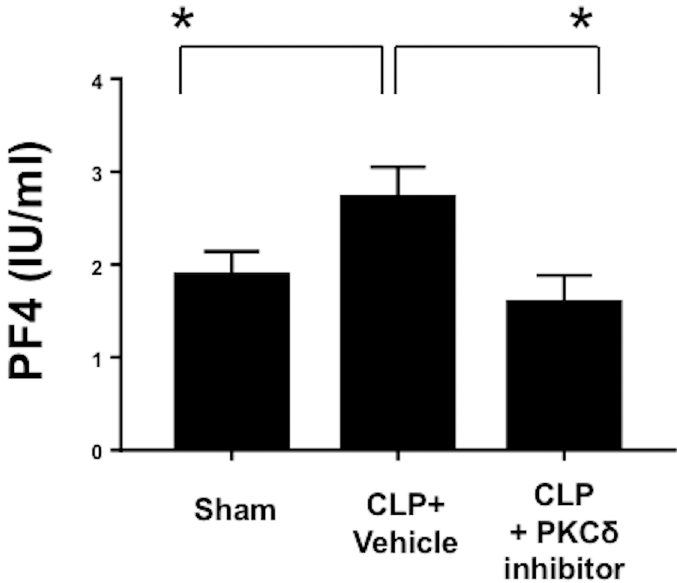
Fig 5. Treatment with the PKC δ inhibitor alters platelet secretion into the lungs of septic rats. PF4 concentration in the BALF was analyzed by ELISA. Data are expressed as International Units (IU)/ml ( (cid:3) p < 0.05; Sham versus CLP plus vehicle and CLP plus vehicle versus CLP plus PKC δ inhibitor, n =